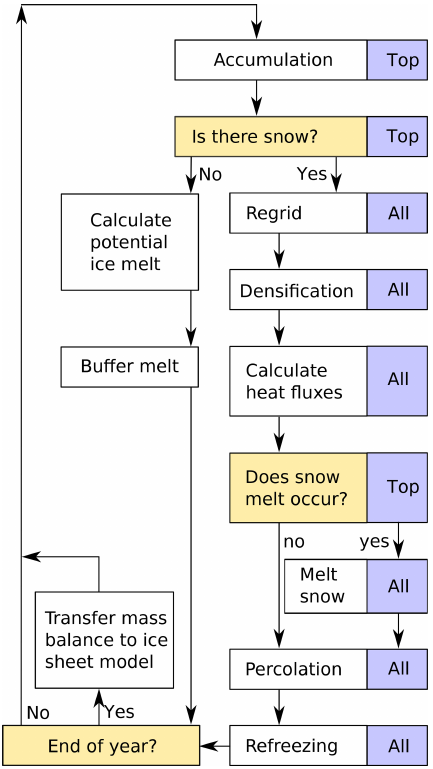
Figure 4. Decision tree at each time step. The blue boxes denote whether the process or question concerns only the top layer or all